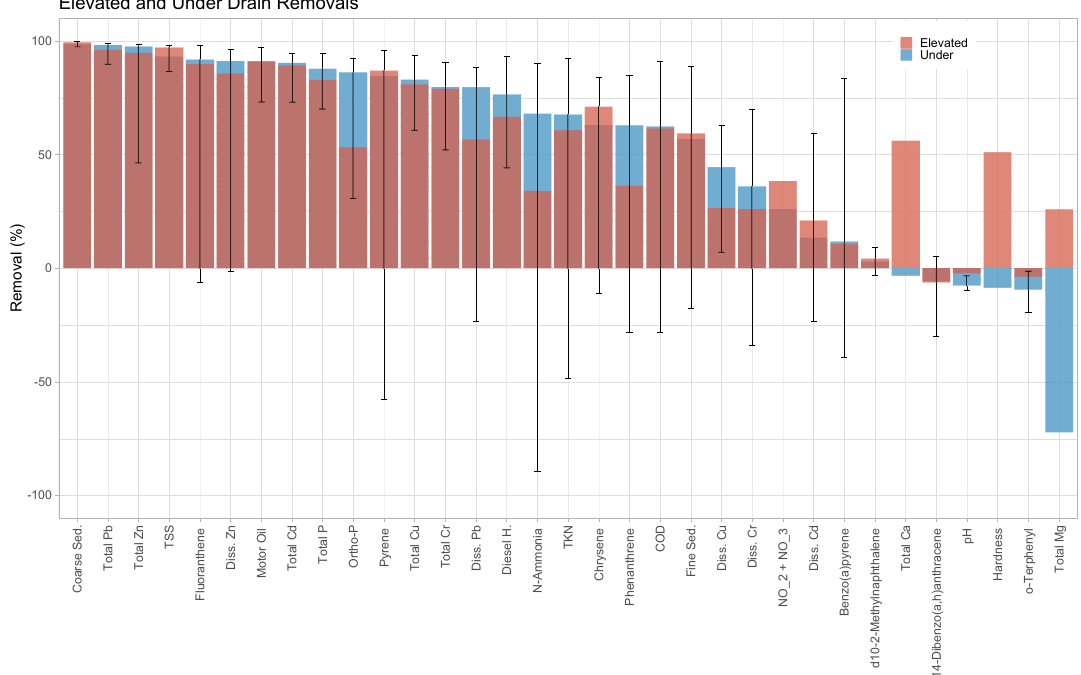
Figure 9. Median removal efficiencies for all analytes ordered from left to right by magnitude of removal at the under drain. Boot strapped confidence intervals for only under drain removals are shown. Only confidence intervals between − 100% and 50% are